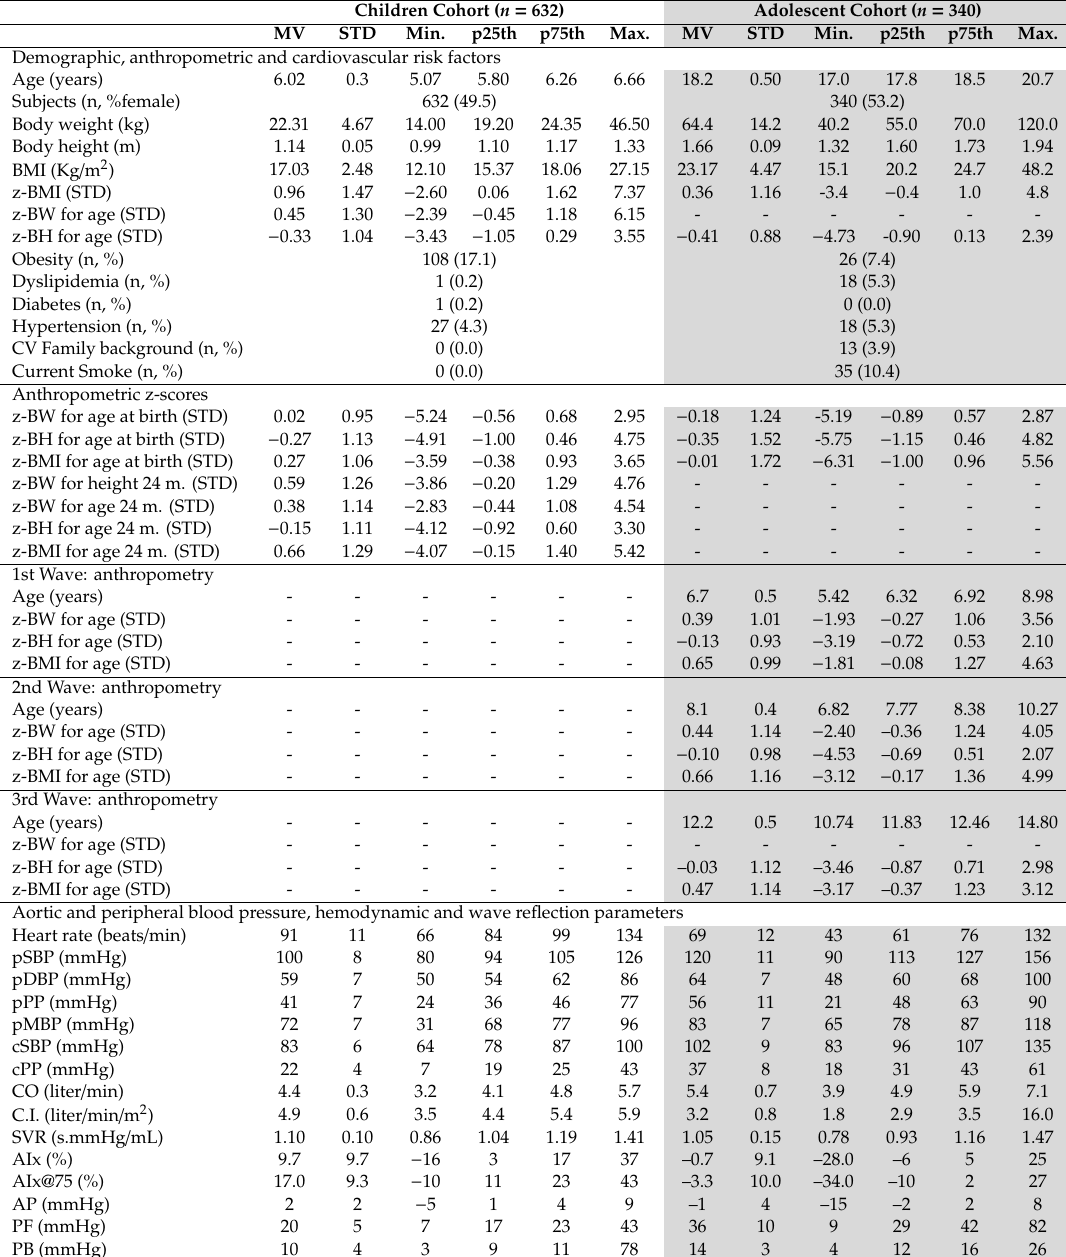
Table 1. Clinical, anthropometric and arterial parameters, of children and adolescent cohorts. Children Cohort ( n = 632) Adolescent Cohort ( n = 340) MV STD Min. p25th p75th Max.